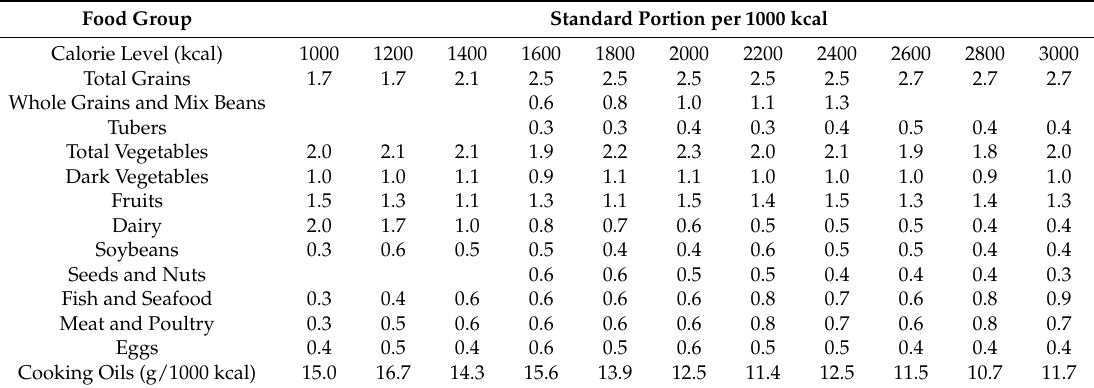
Table 2. Recommended amounts of food groups, expressed in standard portion (SP) per 1000 kcal